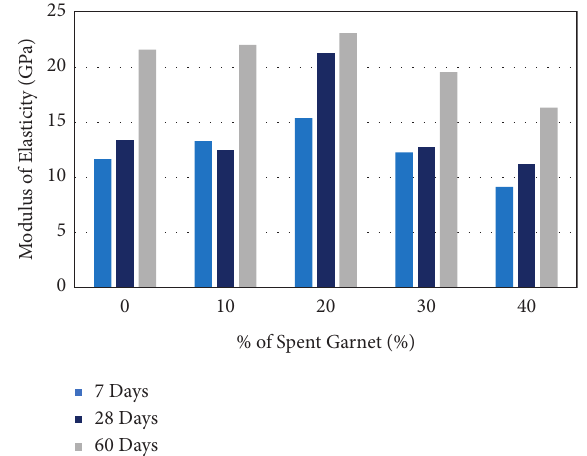
Figure 15: Modulus of elasticity of POC LWAC containing spent